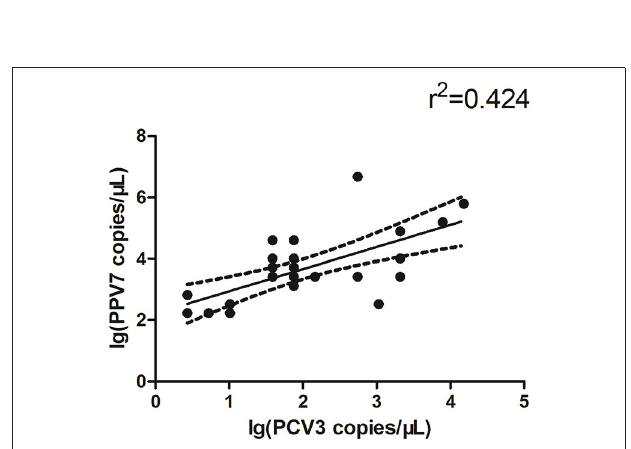
FIGURE 2 | Scatterplots with trends for real-time PCR copy number for PPV7 and PCV3 positive samples ( n = 28, p = 0.0002).